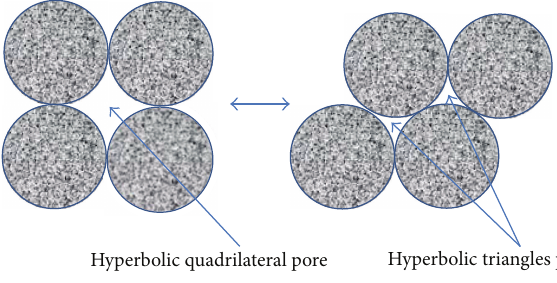
Figure 1: Quadrilateral-triangles stress